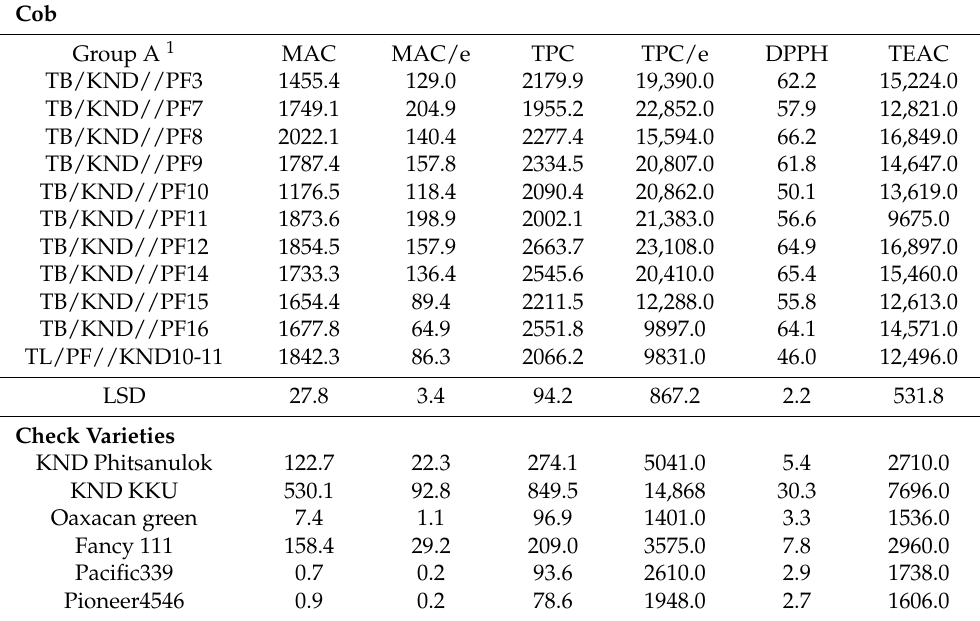
Table 4. Means for monomeric anthocyanin content, total phenolic content and antioxidant